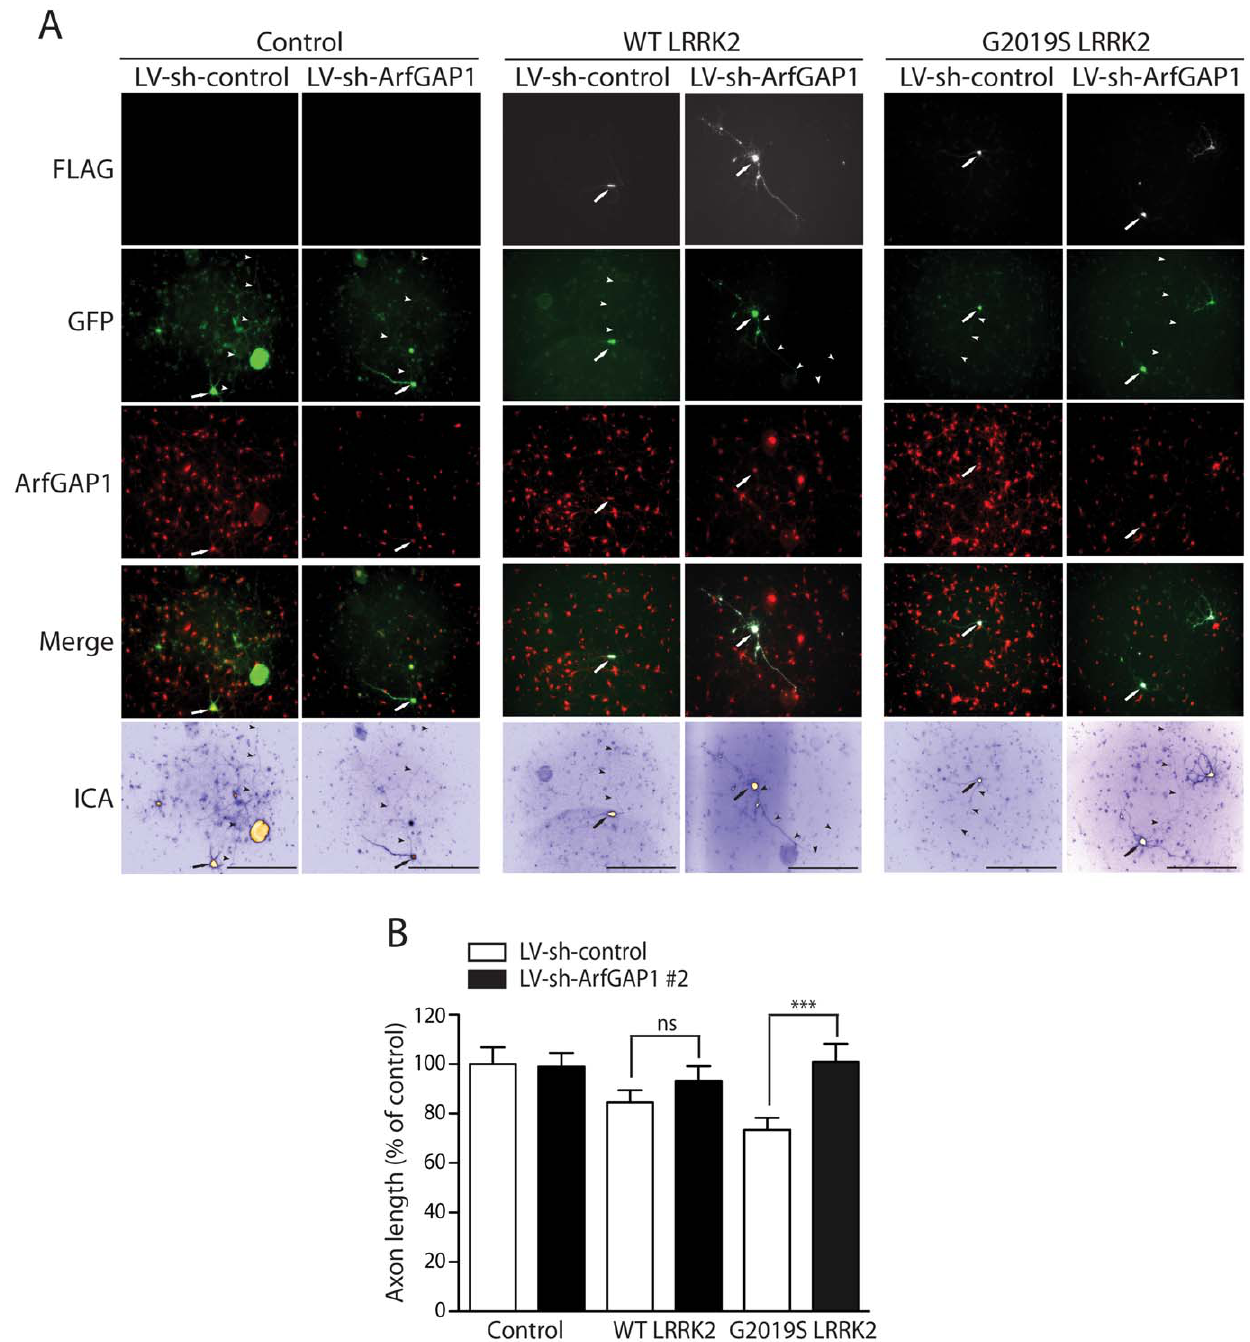
Figure 9. Silencing of ArfGAP1 expression rescues G2019S LRRK2-induced neurite shortening. (A) Primary cortical neurons were infected with lentiviral vectors expressing shRNAs (non-silencing control or ArfGAP1-specific) at DIV 2, subsequently transfected with FLAG-LRRK2 (WT or G2019S) and GFP constructs at a 10:1 molar ratio at DIV 3, and fixed at DIV 6. Fluorescent microscopic images reveal the co-labeling of cortical neurons with FLAG-LRRK2 and GFP. The knockdown of endogenous ArfGAP1 fluorescence signal is also shown following lentiviral expression of ArfGAP1-specific shRNA (LV-sh-ArfGAP1 # 2) compared to control shRNA (LV-sh-control). GFP images were pseudo-colored with ICA for neurite length measurements. Neuronal soma ( arrows ) and axonal processes ( arrowheads ) are indicated. Scale bars: 400 m m. (B) Analysis of GFP-positive axonal processes reveals a robust shortening of axons induced by G2019S LRRK2 expression, and a smaller effect induced by WT LRRK2, compared to GFP alone (control). Knockdown of ArfGAP1 with lentiviral-shRNA vectors produces a complete rescue of G2019S LRRK2-induced axon shortening and a partial rescue of WT LRRK2-induced shortening, compared to control shRNA. Bars represent mean ( 6 SEM) length of axons expressed as a percent of GFP alone (control/LV-sh-control) from . 60 GFP-positive neurons from at least two independent experiments/cultures. *** P , 0.001 comparing LV- sh-ArfGAP1 with LV-sh-control for G2019S LRRK2 by one-way ANOVA with Newman-Keuls post-hoc analysis. ns , non-significant.